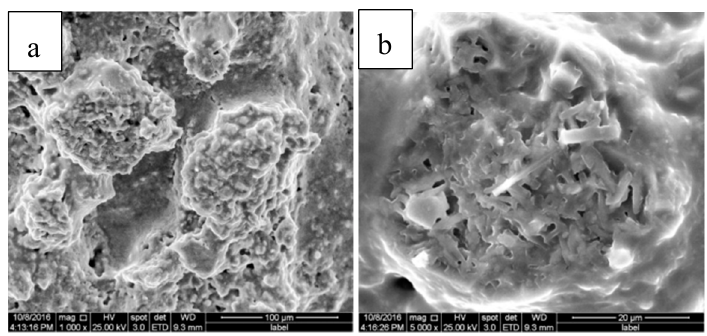
Figure 8. SEM images ( a , b )of microwave roasted reaction products.